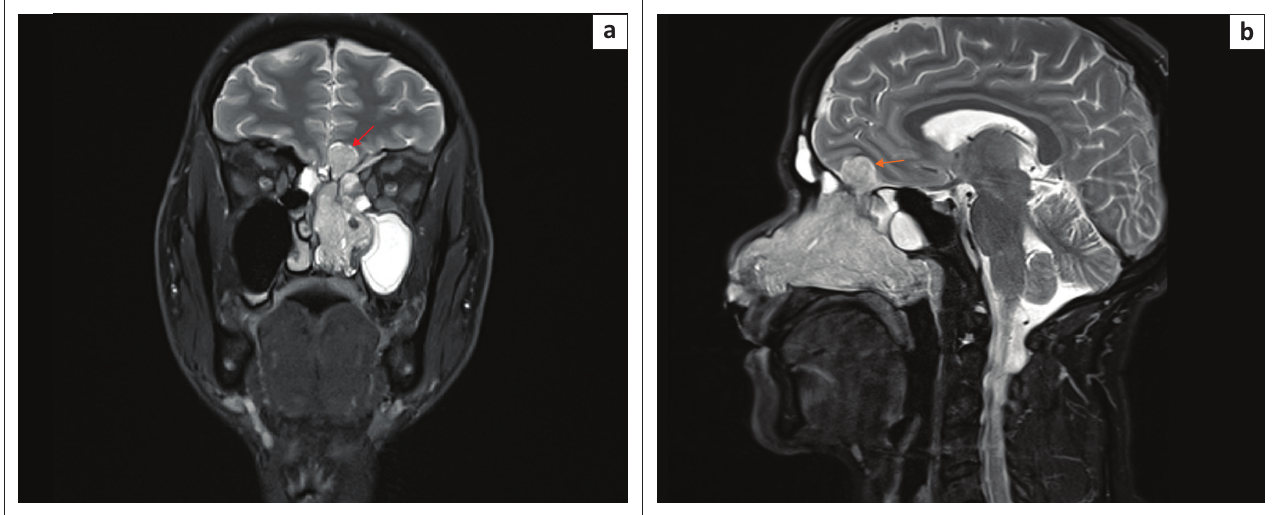
FIGURE 2: (a) Coronal T2 turbo spin echo (TSE) with fat saturation (FS) MRI. There is an expansile T2 solid hyperintense polypoid mass extending intracranially into the anterior cranial fossa with mild mass effect on the inferior left frontal lobe (red arrow). The maxillary sinus is obstructed with a resultant effusion. (b) Sagittal T2 turbo spin echo (TSE) with fat saturation (FS) MRI image shows the antero-posterior extent of the mass, the extradural intracranial component (orange arrow) and obstructed frontal and sphenoid sinuses.